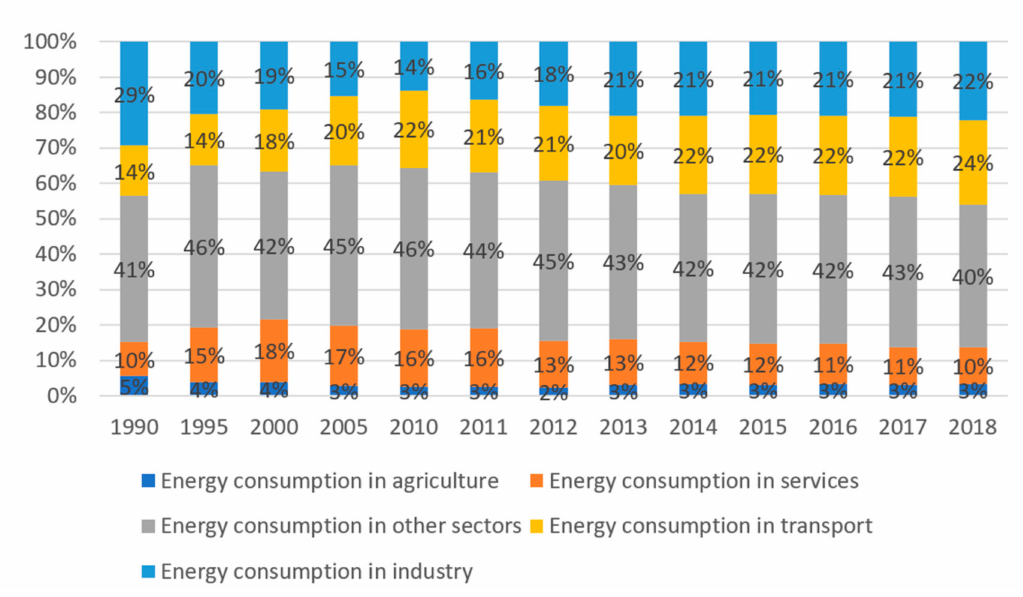
Figure 7. Structure of energy consumption in Hungary in